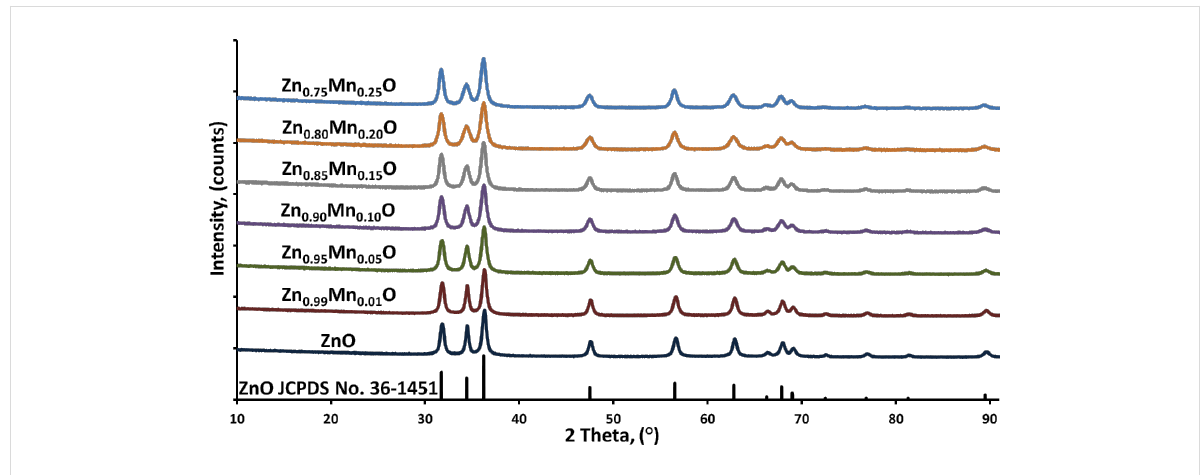
Figure 5: XRD diffraction patterns of Zn 1 − x Mn x O NPs, with the nominal dopant content in the solution being 0, 1, 5, 10, 15, 20, 25 mol % and its com- parison with the standard pattern of wurtzite-phase ZnO (JCPDS No. 36-1451).